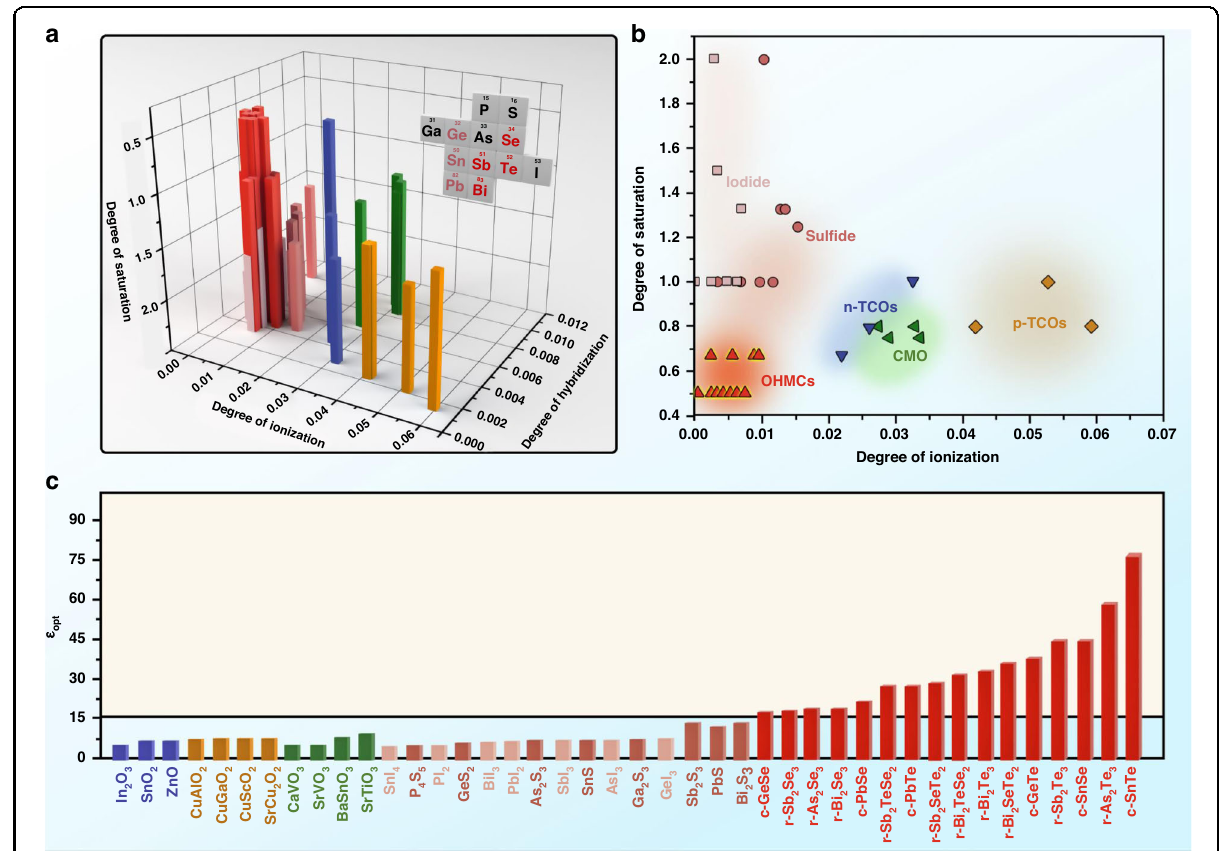
Fig. 4 Map of high- ε opt material. a 3D graphs of the ionization, hybridization, and saturation of different materials. The inset in the upper right corner shows the elements of the candidate compounds. Five types of system are shown: heavy-metal chalcogen compounds of type IV 1 VI 1 and V 2 VI 3 (red), n-type transparent conductive oxide (blue), p-type transparent conductive oxide (orange), correlated metal oxonates (green), sul fi de (pale- red) and iodide (pink). b 2D graphs of the ionization and saturation of the same material. The material in the bright-red area meets all the three principles. The material in the pale-red area has a high degree of hybridization. Materials outside the bright-yellow and pale-yellow area are highly ionized or highly saturated. c ε opt of the same material. The bright yellow materials that meet all the three principles are high- ε opt with ε opt >